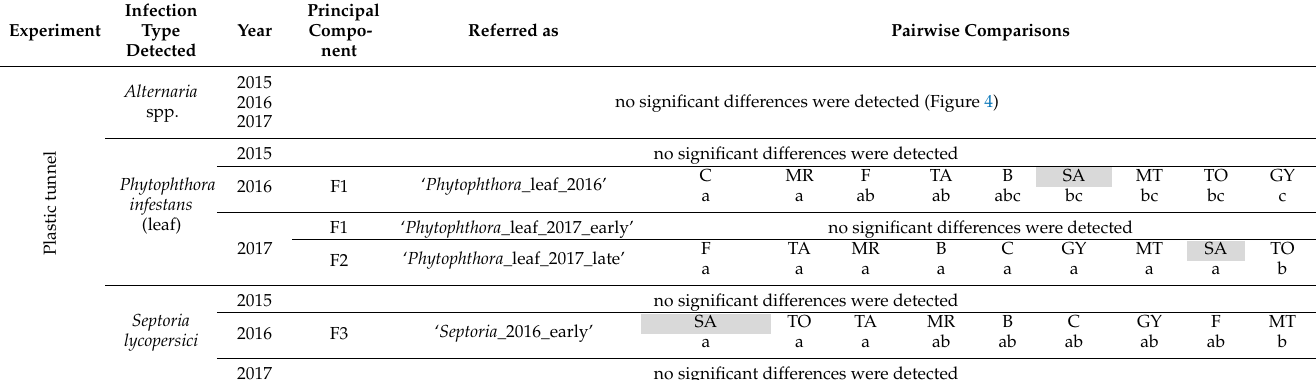
Table 9. The post hoc test results of the significant PCs obtained from the infection data of the different tomato landrace gene bank items and control varieties regarding the plastic tunnel experiment. Different letters from lower to higher rate of infection represent significantly different groups (Games-Howell’s, p < 0.05). Abbreviations of the Hungarian landrace gene bank items are: B: ‘Balatonbogl á r’; C: ‘Cegl é d’; F: ‘Fadd’; GY: ‘Gyöngyös’; MR: ‘M á riap ó cs’; MT: ‘M á trafüred’;